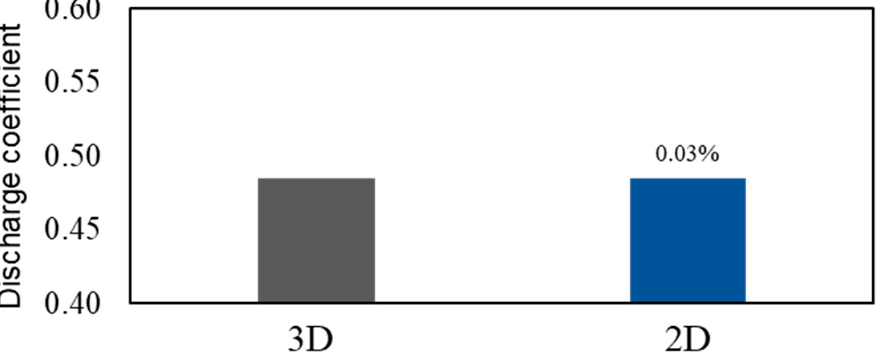
Figure 4. Comparison of the 2D and 3D discharge coefficients of the straight-through labyrinth seal.